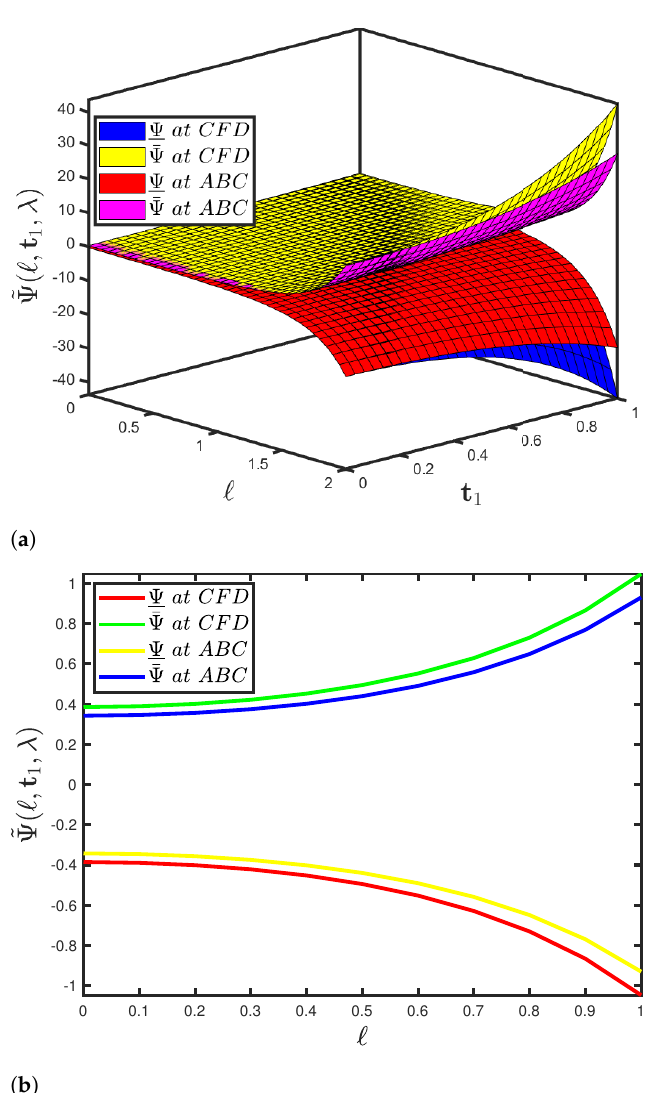
Figure 16. Comparison plots of ˜ Ψ ( (cid:96) , t 1 ; λ ) of Problem (4) when fuzzy CFD and ABC are considered to have a fractional order ϑ = 1 and uncertainty parameter λ ∈ [ 0,1 ] : ( a ) three-dimensional plot; ( b ) two-dimensional plot of Ψ ( (cid:96) , t 1 ; λ ) and ¯ Ψ ( (cid:96) , t 1 ; λ ) when and t 1 =